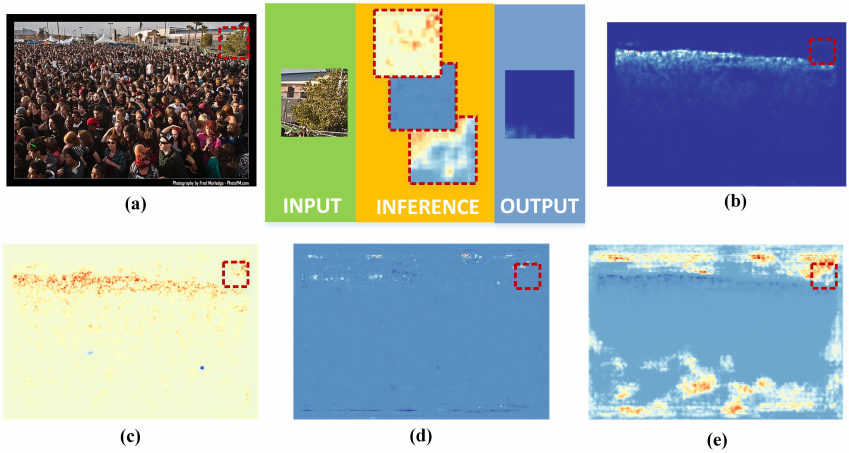
Figure 3. Analysis of the context fusion module (CFM). The outputs of CFM are visualized, and the red bounding boxes mark the same spatial region in different maps. In the feature maps, the color from red to blue reflects the response from strong to weak. ( a ) Input image, ( b ) estimation result, ( c ) first output of CFM, ( d ) second output of CFM, and ( e ) third output of